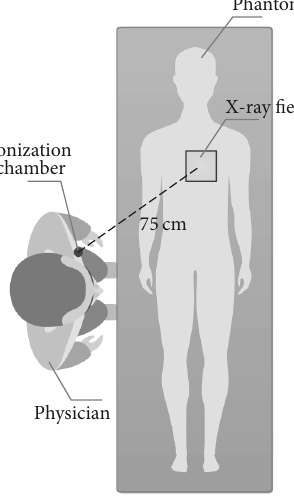
Figure 1: The geometry of measurement on the angiography system for cardiology.